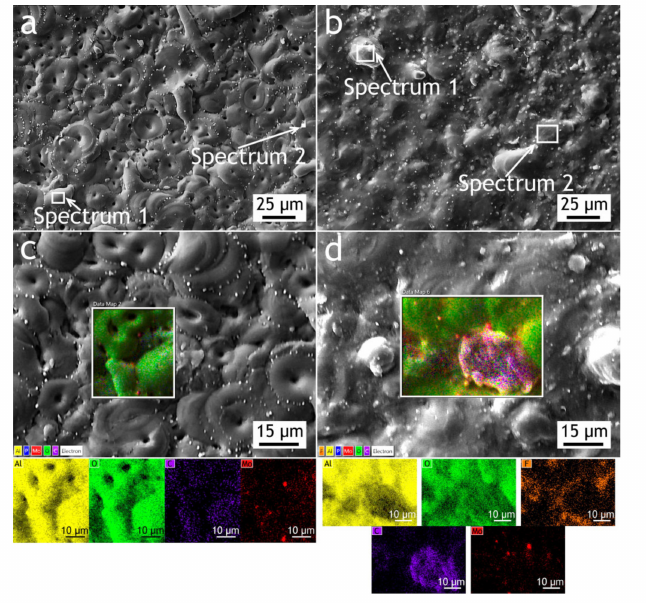
Figure 3. SEM images and EDX maps of the PEO-coating—( a , c ) and composite coatings (CC)—( b , d